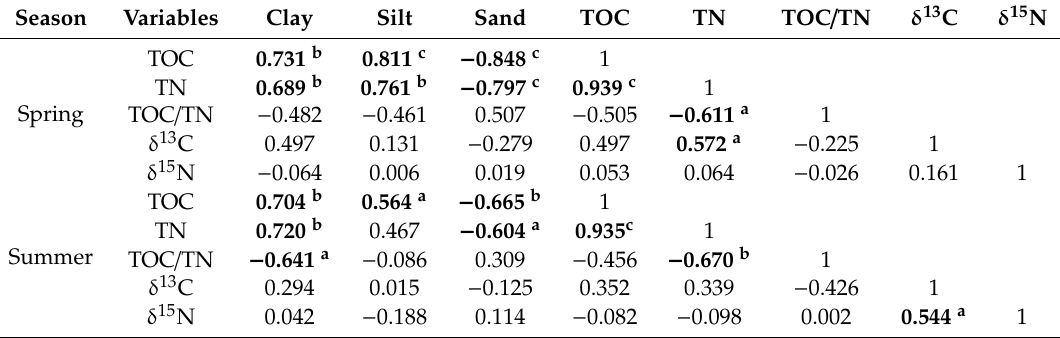
Table 3. Relationship between sediment carbon and nitrogen parameters and sediment grain-size fractions in spring and